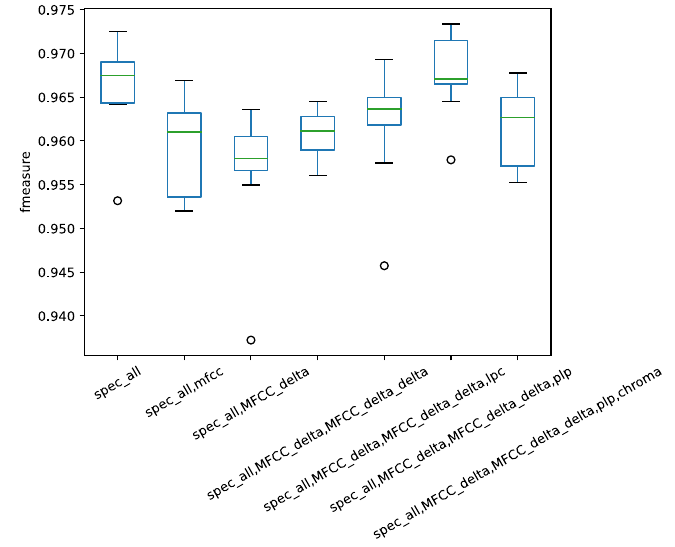
Figure 8. Performances of different combinations of features on the RWC